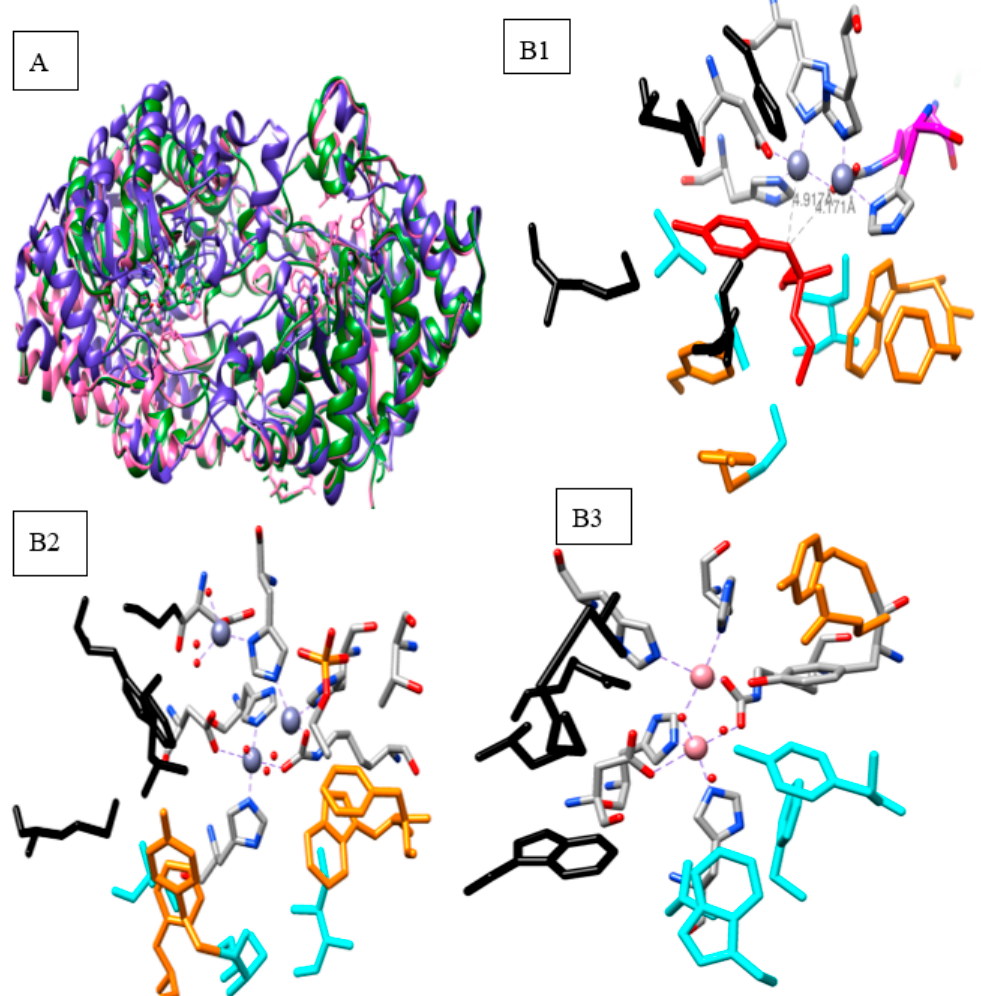
Figure 2. Superposition of 3D structure and substrate binding sites of phosphotriesterase. (A) Colored pink: Pseudomonas dimunita PTE; green: Sphingobium fuliginis PTE ; blue: Geobacillus